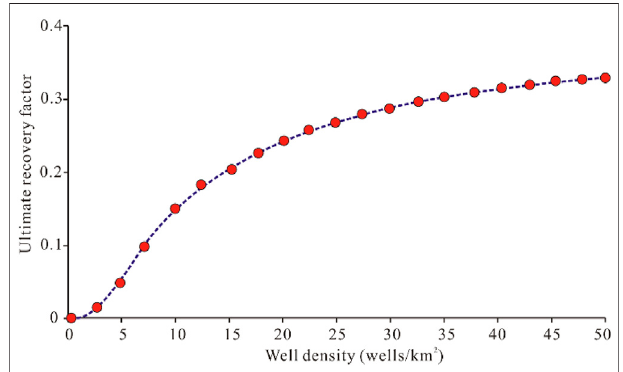
FIGURE 12 | Relationship between well pattern density and ultimate recovery factor.